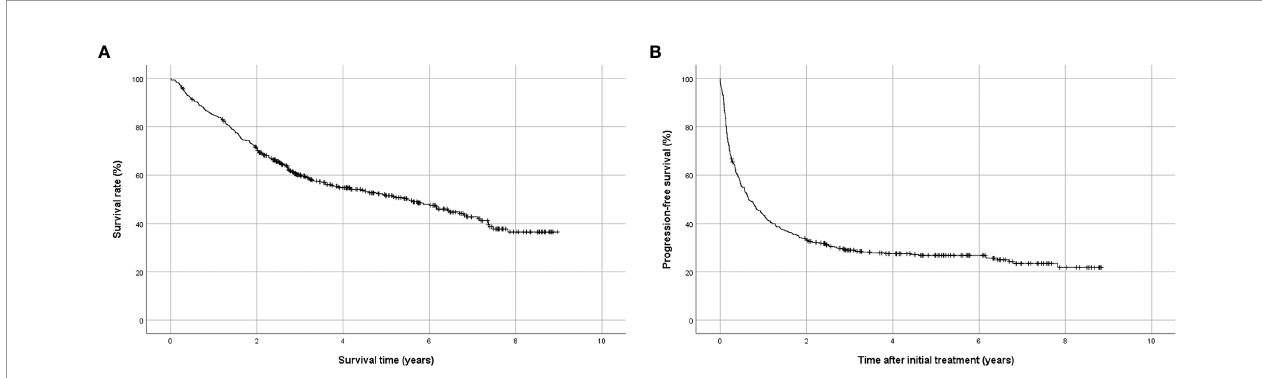
FIGURE 2 | Kaplan-Meier analysis of survival using the Korean Primary Liver Cancer Registry database. (A) Overall survival, (B) progression-free